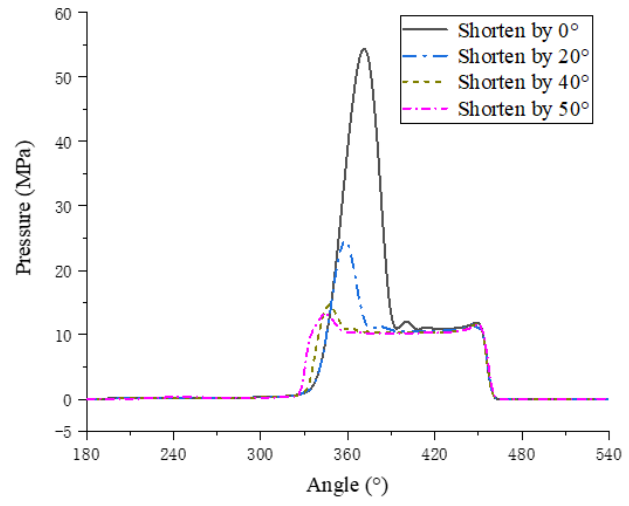
Figure 19. The pressure of P2 at different profile lengths.